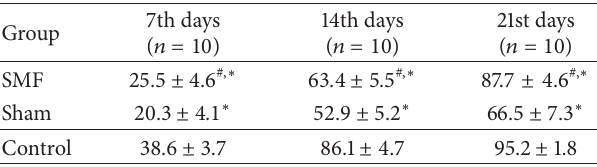
Table 1: Comparison of wound healing rate between three groups ( 𝑥 ± 𝑠 ,